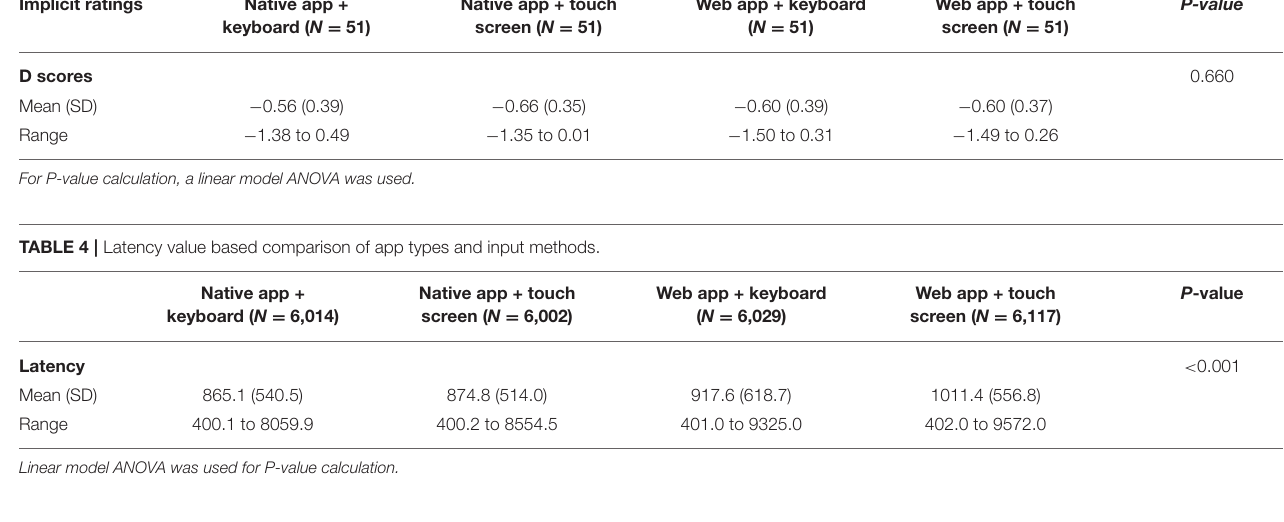
TABLE 3 | D scores representing implicit preferences vs. combination of app type and input method. Implicit ratings